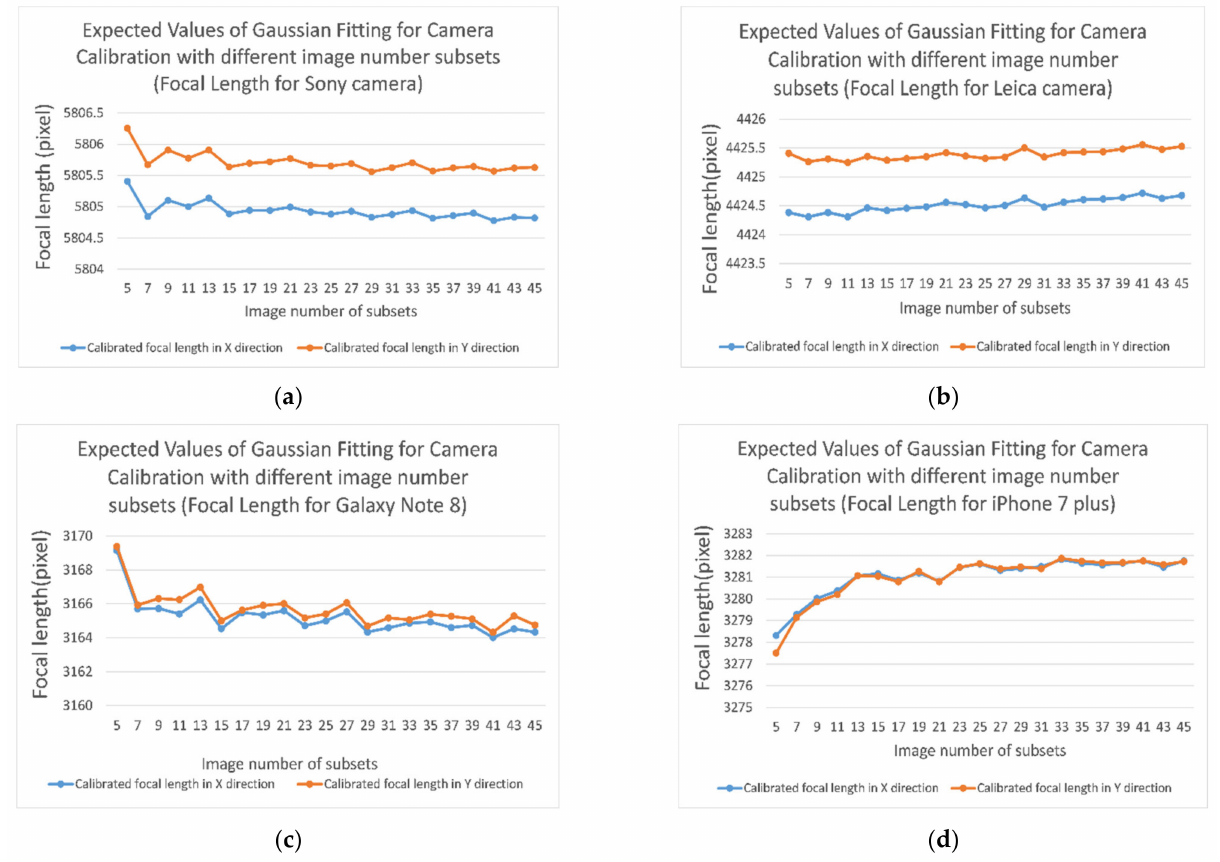
Figure 20. Gaussian fitting standard deviations for the calibrated focal length of four camera systems: ( a ) Sony α 7R II focal length; ( b ) Leica Q focal length; ( c ) Samsung Galaxy Note 8 focal length; and ( d ) Apple iPhone 7Plus focal